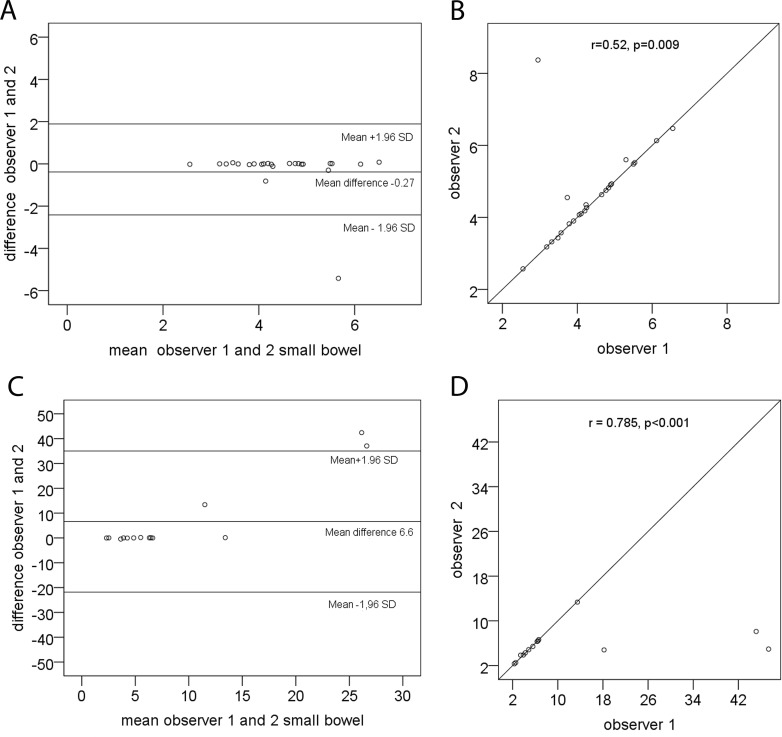
Interobserver analyses from small bowel.Scatter plots and Bland-Altman plots with limits of agreement depicting bias and error between observer 1 and observer 2 for detection of small bowel transit time recorded with wireless motility capsule in healthy controls (2A,B) and in patients with Familial GUCY2C Diarrhea Syndrome (2C,D).